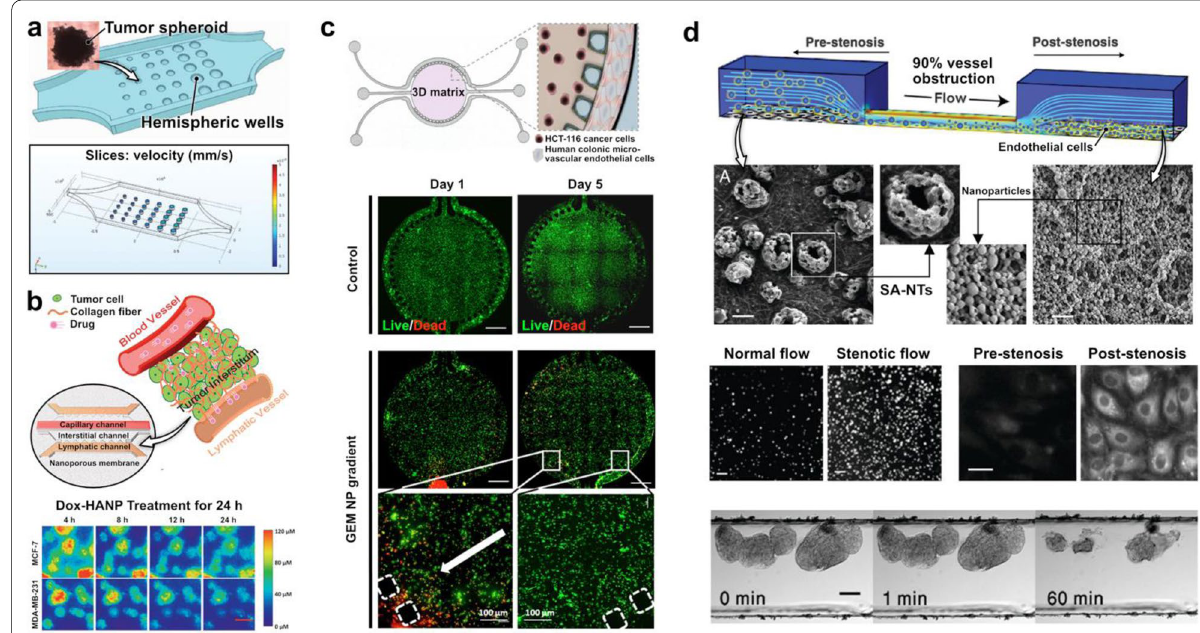
Fig. 4 Assessing therapeutic efficacy of nanoparticles. a A tumor-on-a-chip model to flow paclitaxel (PTX)-loaded nanoparticles across tumor spheroids held in hemispheric wells. Under flow conditions, the platform demonstrated increased treatment efficacy for high doses and lower flow rates. b A tumor-microenvironment-on-a-chip was used to assess the effect of doxorubicin-loaded hyaluronic acid nanoparticles (Dox-HANP). Nanoparticles accumulated more near MCF-7 cells breast cancer cells than MDA-MB-231 breast cancer cells. Scale bar, 50 µm. c A human colorectal tumor model was used to culture colon cancer cells in a circular central chamber and endothelial cells in the side channels. Introduction of gemcitabine (GEM)-loaded dendrimer nanoparticles showed a gradient dependent decay of cancer cell viability. Scale bars, 100 µm. d Novel shear-activated nanotherapeutics (SA-NTs) were flowed through a microfluidic device modelling a constricted vessel in the study of stenosis. High shear forces resulted in the SA-NTs breaking into individual nanoparticles, resulting in 10 times more nanoparticles after stenotic flow compared to normal flow. Greater accumulation was observed at endothelial cells post-stenosis than pre-stenosis. When SA-NTs were coated with a thrombolytic drug, the individual nanoparticles were able to accumulate at fibrin clots and dissolve them. Scale bars, 2 µm (top), 2 µm (middle left), 20 µm (middle right), 100 µm